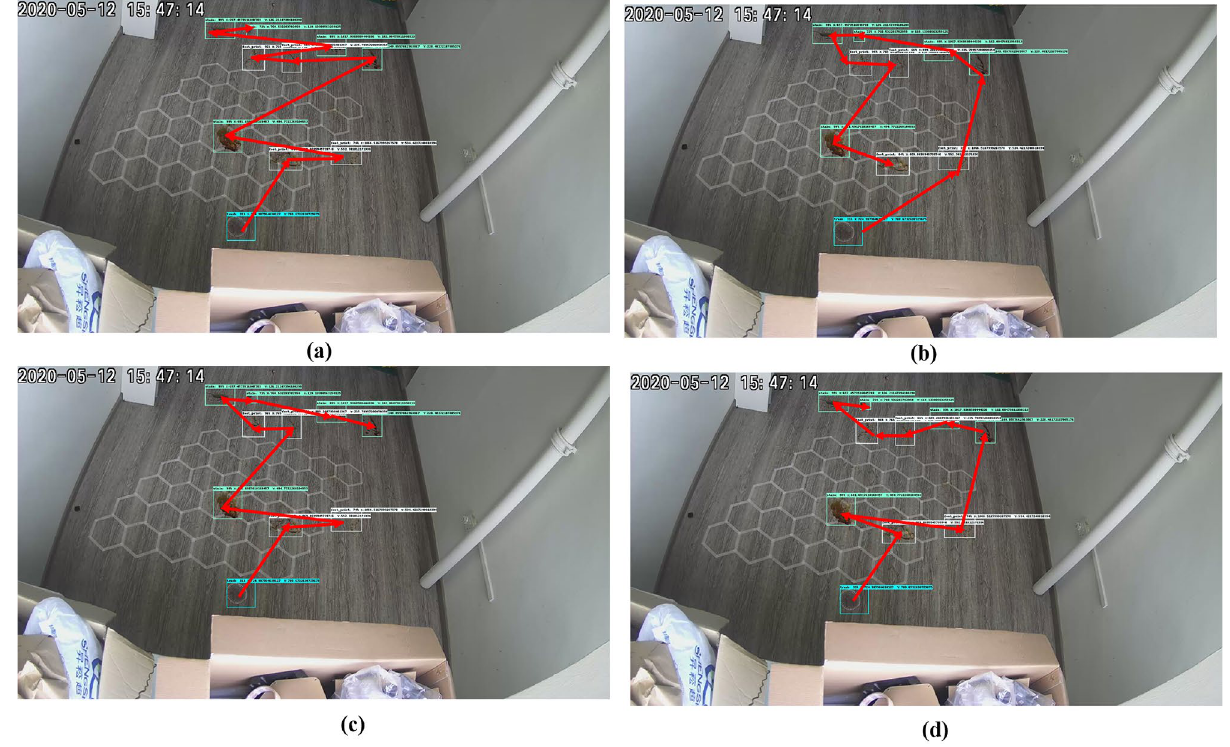
Figure 7. The trajectories of the tested method for workspace-1. ( a ) zigzag; ( b ) spiral; ( c ) greedy search; ( d )